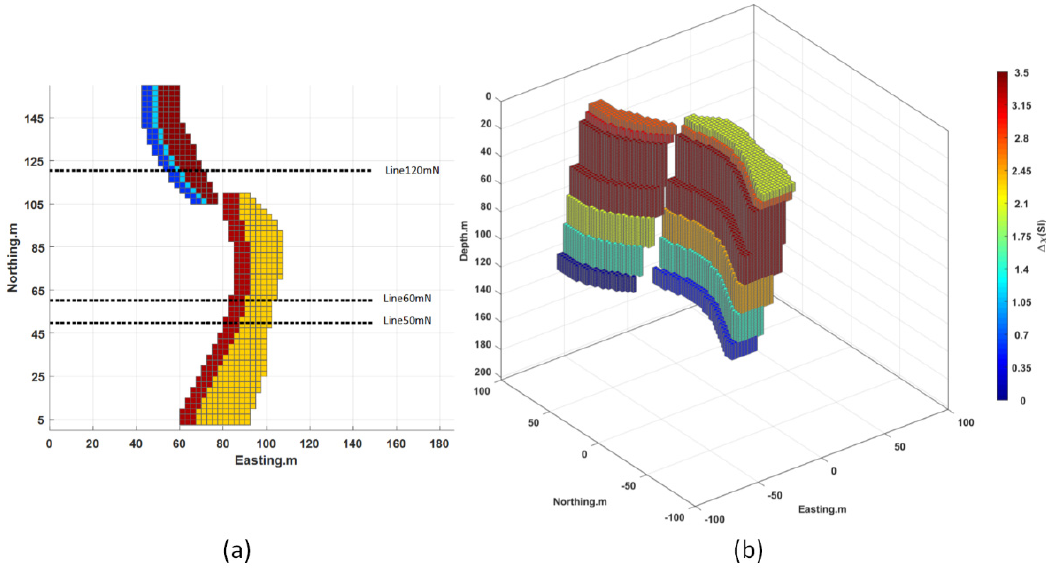
Figure 15. Geology of the Tallawang magnetite skarn. Test line is 50 mN, 60 mN, 120 mN. (Redraw from Schmidt et al., 2004) [4]. ( a ) Plane graph; ( b ) Sheer plan. In Figure 15, the 50 mN, 60 mN and 120 mN lines all cross the magnetite vein, but the 120 mN and 60 mN lines are far apart and contain an east-west-northwest fault. There is not enough line data to reflect the real mine morphology, so we only take the two-di- mensional plan composed of the 50 mN and 60 mN line data for local prediction and in- version interpretation, as shown in Figure 16.